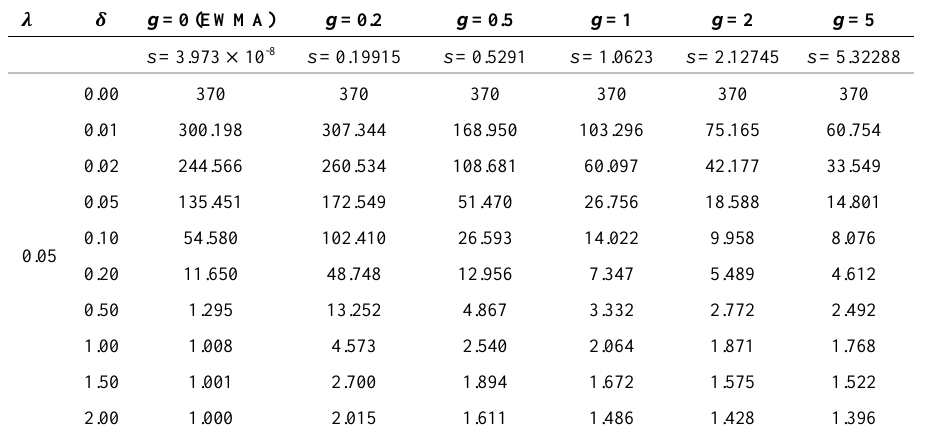
Table 7. Compare the modified EWMA charts on the FIMA (1/2,2) model of the price of WTI crude oil at various λ and